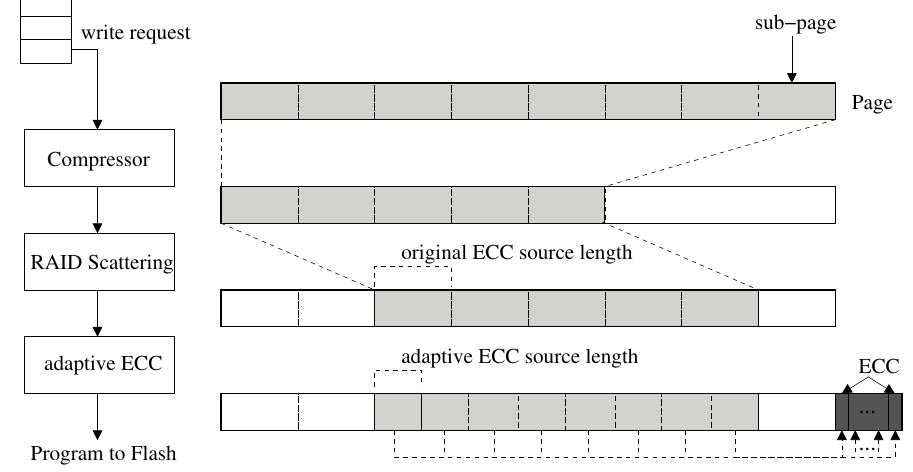
Figure 3. Data write procedure with compression-assisted adaptive ECC and RAID